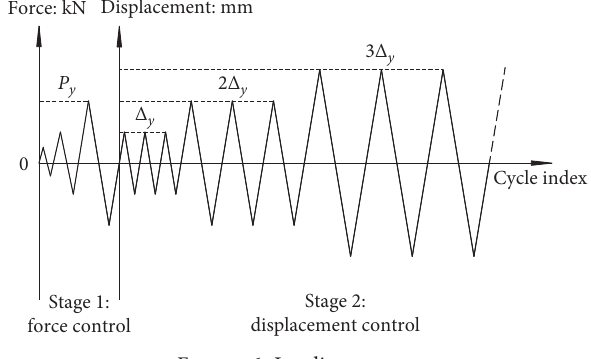
Figure 6: Loading